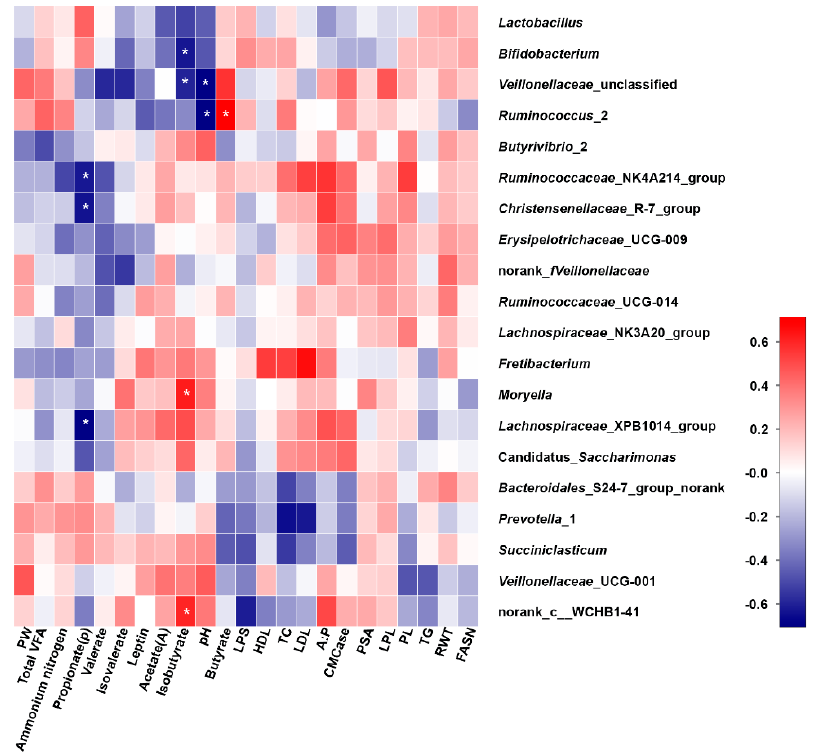
Figure 6. Correlations among rumen morphological parameters, rumen fermentation parameters, CMCase activity, serum biochemical indices and bacterial genera affected by different feed types of mulberry leaves. PL ‐ papilla length, PW ‐ papilla width, PSA ‐ papilla surface area, RWT ‐ rumen wall thickness, CMCase activity ‐ carboxymethylcellulase activity, LPS ‐ Lipase, HDL ‐ high ‐ density lipoprotein cholesterol, LDL ‐ low ‐ density lipoprotein cholesterol, TC ‐ Total cholesterol, LPL ‐ lipoprotein lipase, TG ‐ triglycerides, FASN ‐ fatty acid synthase. Corrected p < 0.05 was marked with *.